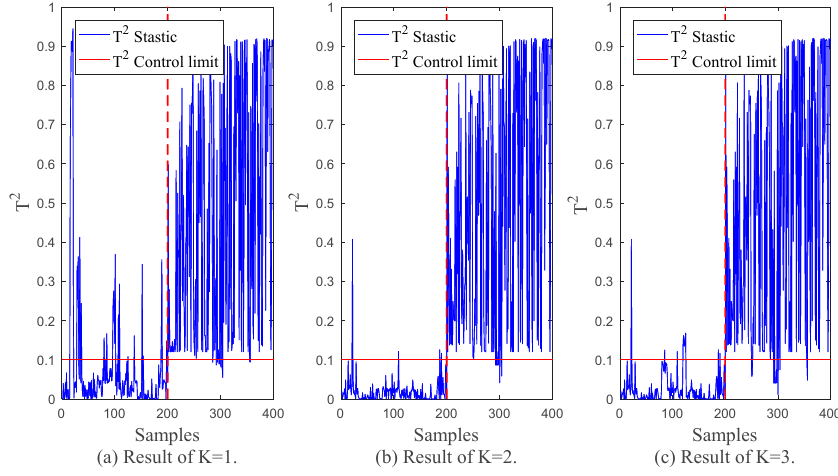
Figure 7. FDALM results at different K .